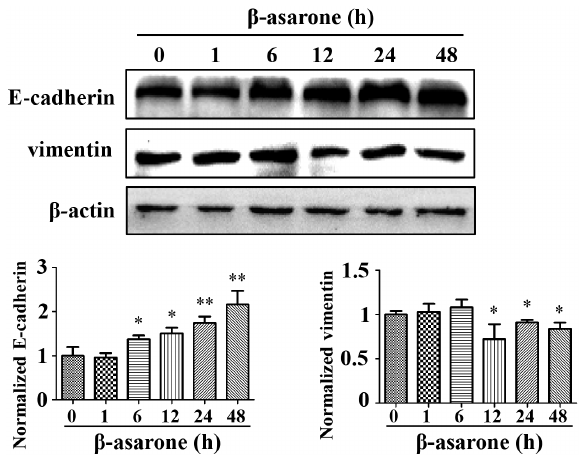
Figure 3. β -asarone modulated the expression of EMT markers E-cadherin and vimentin. Cells were treated with β -asarone (60 μ M) for the indicated time and the expression of E-cadherin and vimentin was analyzed by Western blotting. The blots were representative of three independent experiments. * p < 0.05 and ** p < 0.01 compared with vehicle.